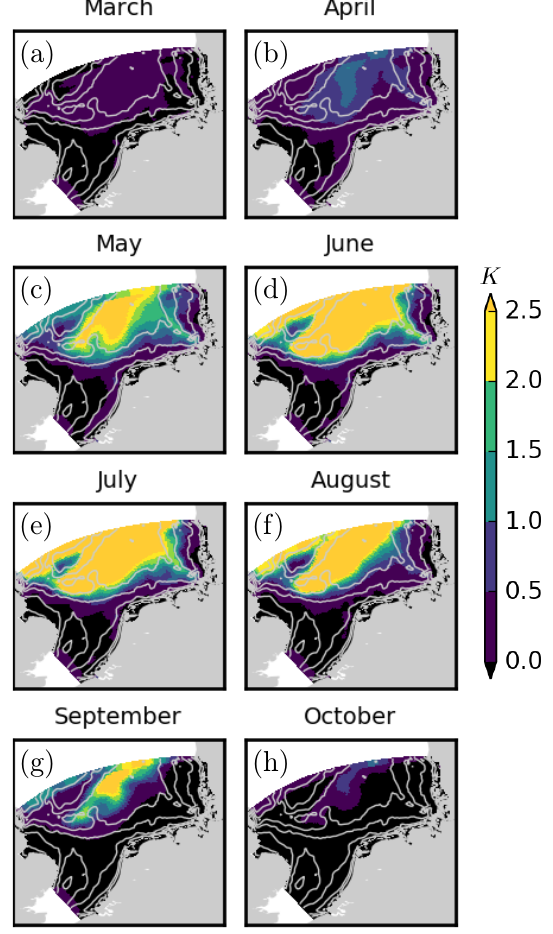
Figure 10. Average temperature difference (K) between the surface and bottom layers, averaged throughout 2000–2010 for each month. Gray lines show the